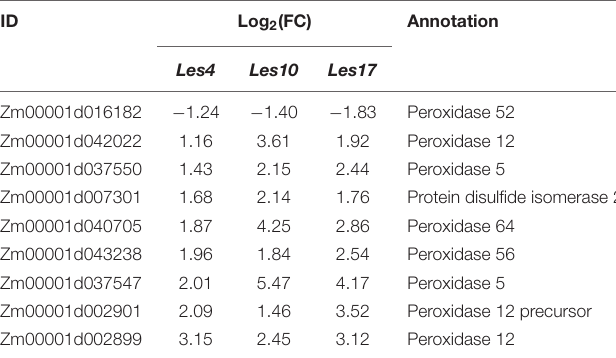
TABLE 2 | Common differentially expressed genes involved in generation of reactive oxygen